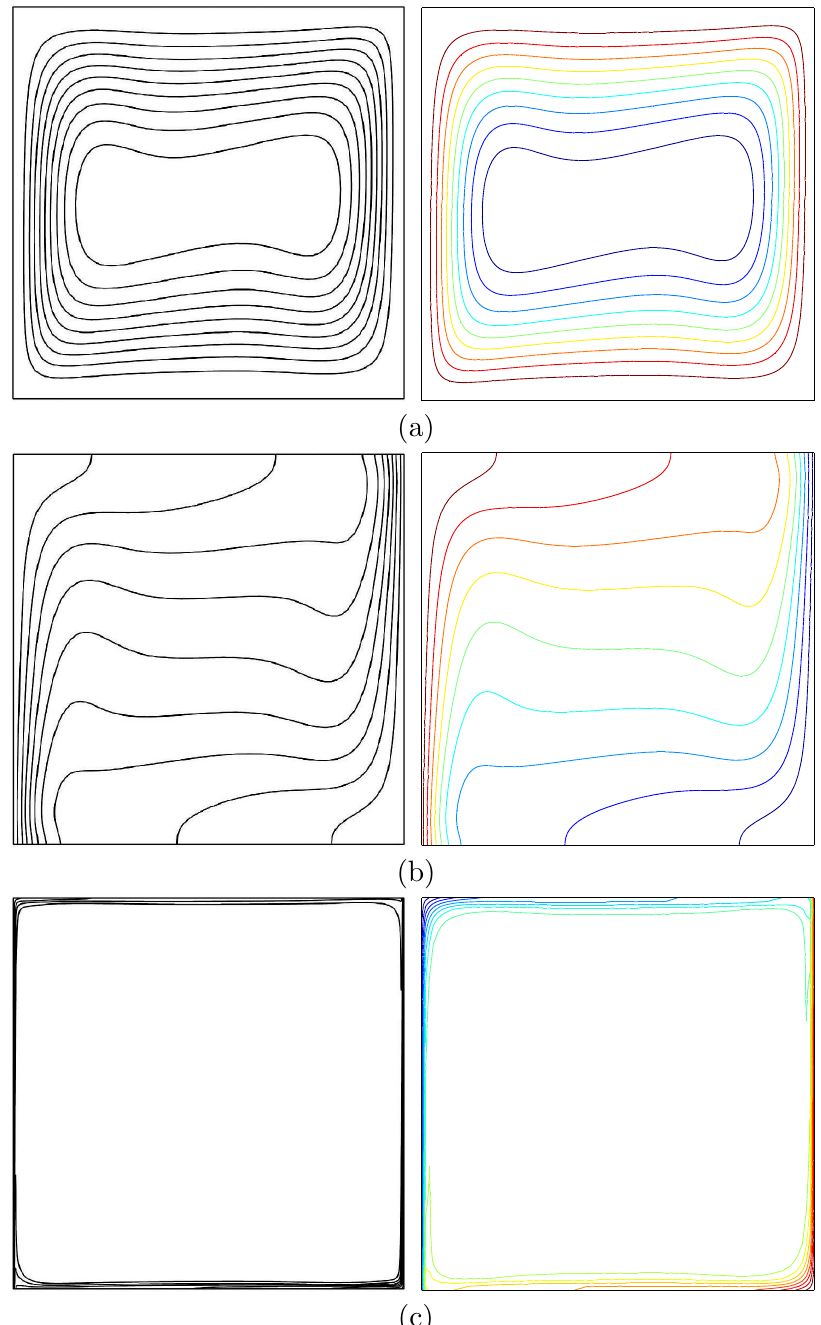
Figure 3. (left) Corcione et al. [37] and (right) current work for ( a ) streamlines, ( b ) isotherms and ( c ) nanoparticle distribution at Ra = 3.37 × 10 5 , N = 0, φ = 0.04, H = 1 and D =